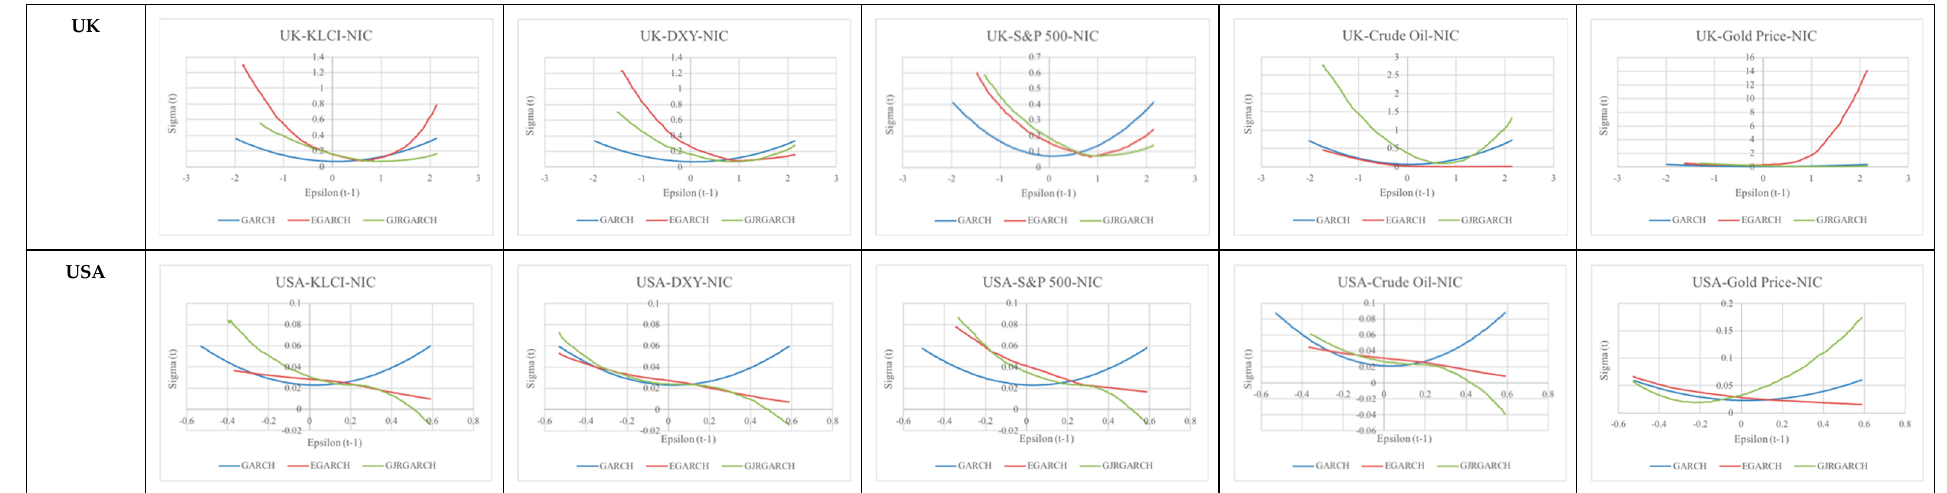
Figure 6. The 50 news impact curves in three volatility models with five financial news shocks.